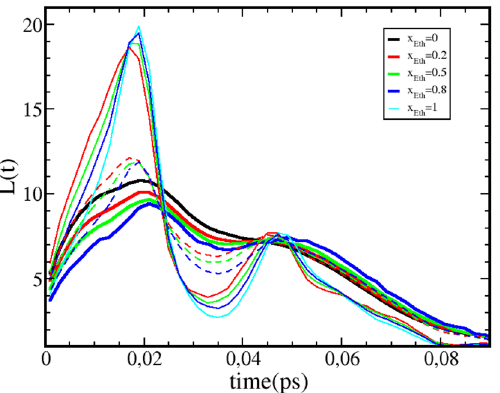
Figure 4. Close-up of the secondary and tertiary peaks of H-bond life time distributions L ( t ) of oxygen atoms 3.5˚ A for water–ethanol mixtures and for r c = and different ethanol concentrations. Water–water curves are in full lines, ethanol–ethanol lines in thin full lines, and water–ethanol cross contributions in dashed lines.